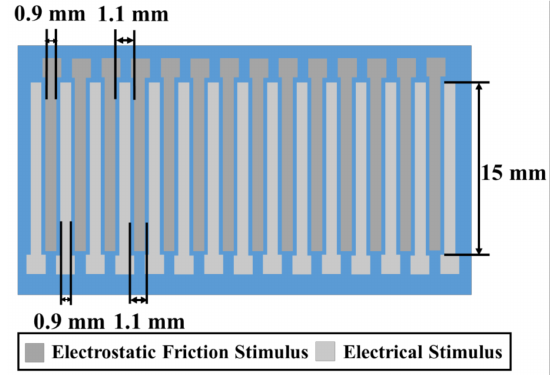
Figure 3. Electrode design of the tactile display.